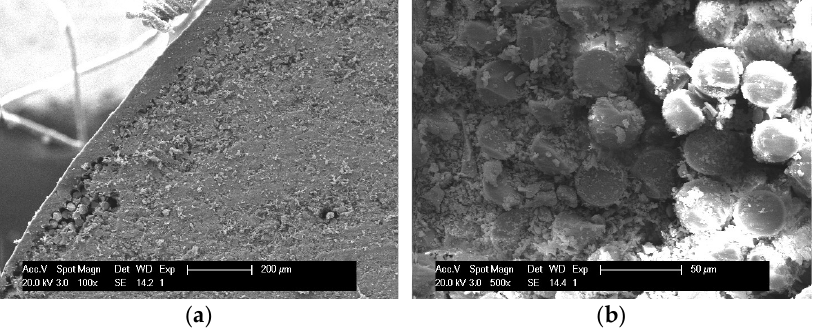
Figure 11. Microstructure of G1 after accelerated aging at 20 °C for 180 days: ( a ) 100 × G1; ( b ) 500 × G1.